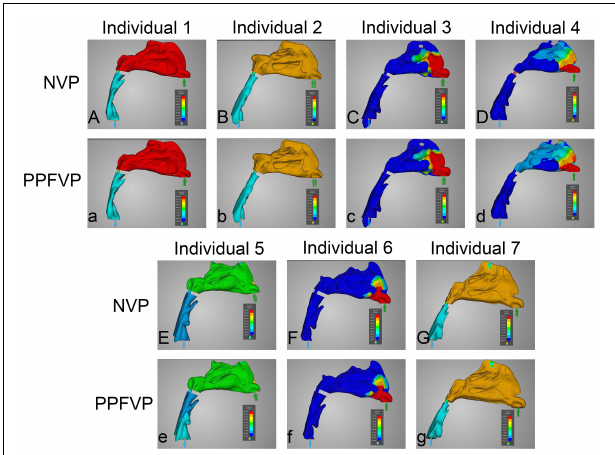
FIGURE 3 | Airflow pressure patterns through the upper airways. The airflow pressure patterns of seven individuals were demonstrated. The color of the airflow was used to show the pressure changing in the same model. NVP, normal velopharyngeal closure (one port); PPFVP, velopharyngeal closure after posterior pharyngeal flap palatoplasty (two ports). The scale bar cannot be fixed because of the real-time simulation process in which the scale bar was changing with time.